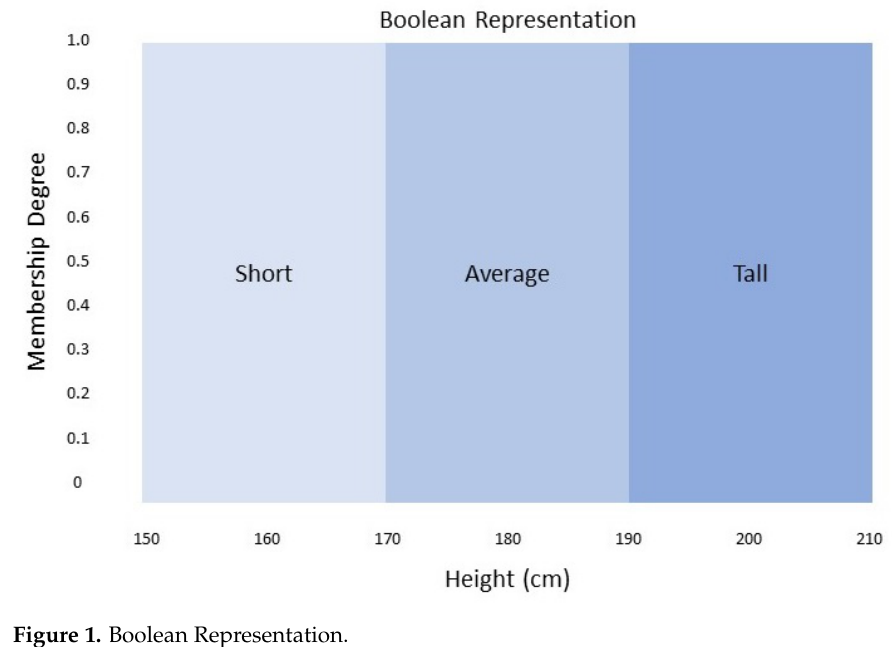
Figure 1. Boolean Representation.